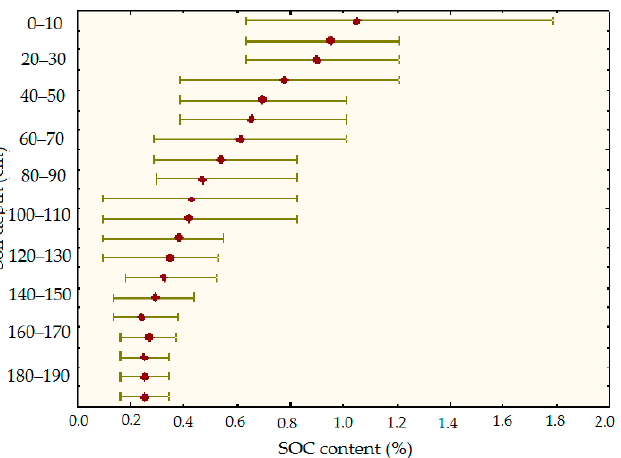
Figure 8. Vertical distribution of soil organic carbon (SOC) content in soil profile of vineyards, <200 cm (N = 60).